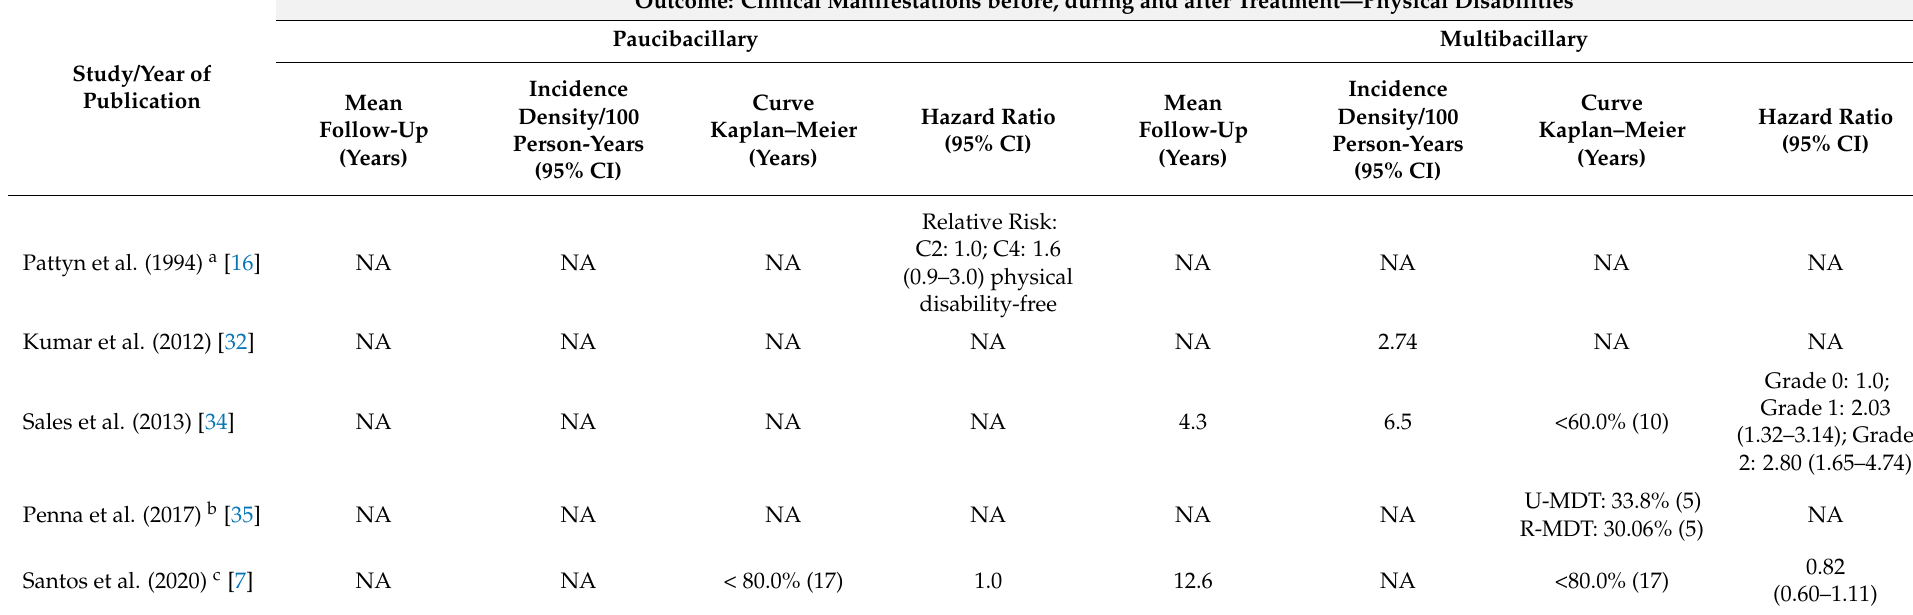
Table 6. Reporting survival analyses of the included studies by outcome clinical manifestations before, during and after treatment—physical